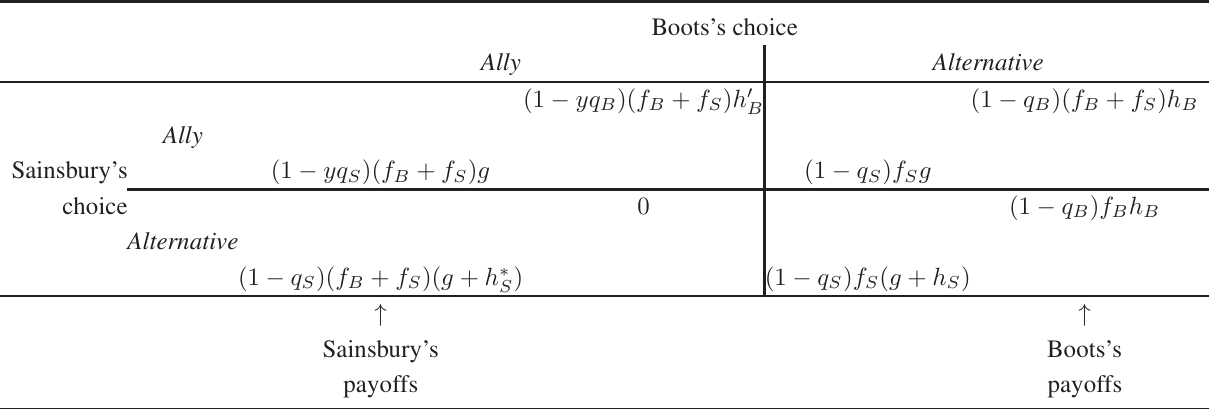
Table 3. Payoffs with a third player and improved market